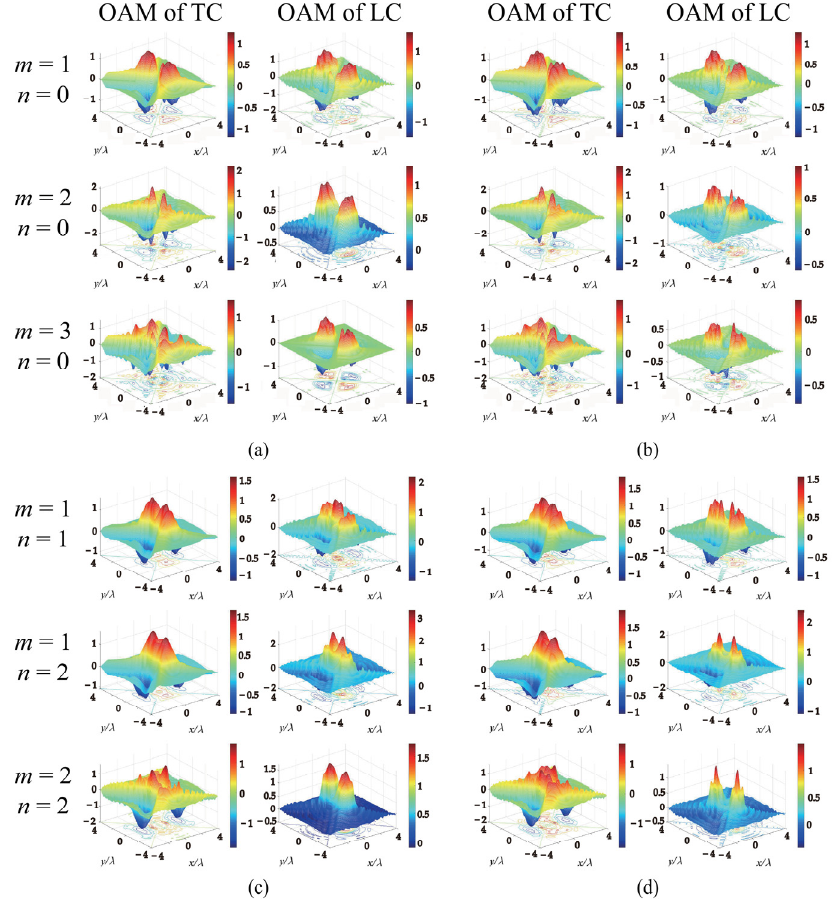
Figure 7. The OAM distribution of a focused twisted vector vortex beam in the focal region: ( a , c ) the locally linear polarization ( ∆ φ = 0 in Equation (1)); ( b , d ) the hybrid SOP ( ∆ φ = π /2 in Equation (1)). Here, the size of each plot is set as 4 λ × 4 λ . The initial phase is φ 0 = 0 and the twisted strength is u = 10 13 mm − 2